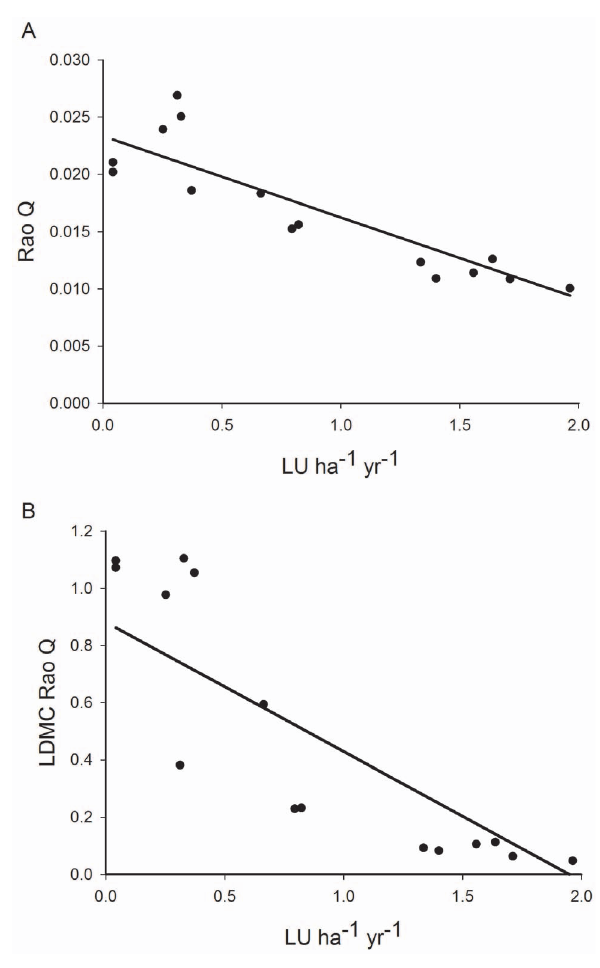
Figure 2. Productivity:functional diversity relationships. Fitted relationships between plot mean production ((LU ha 2 1 yr 2 1 ) and (A) mean plot Rao’s Q and (B) mean plot LDMC Rao’s Q.